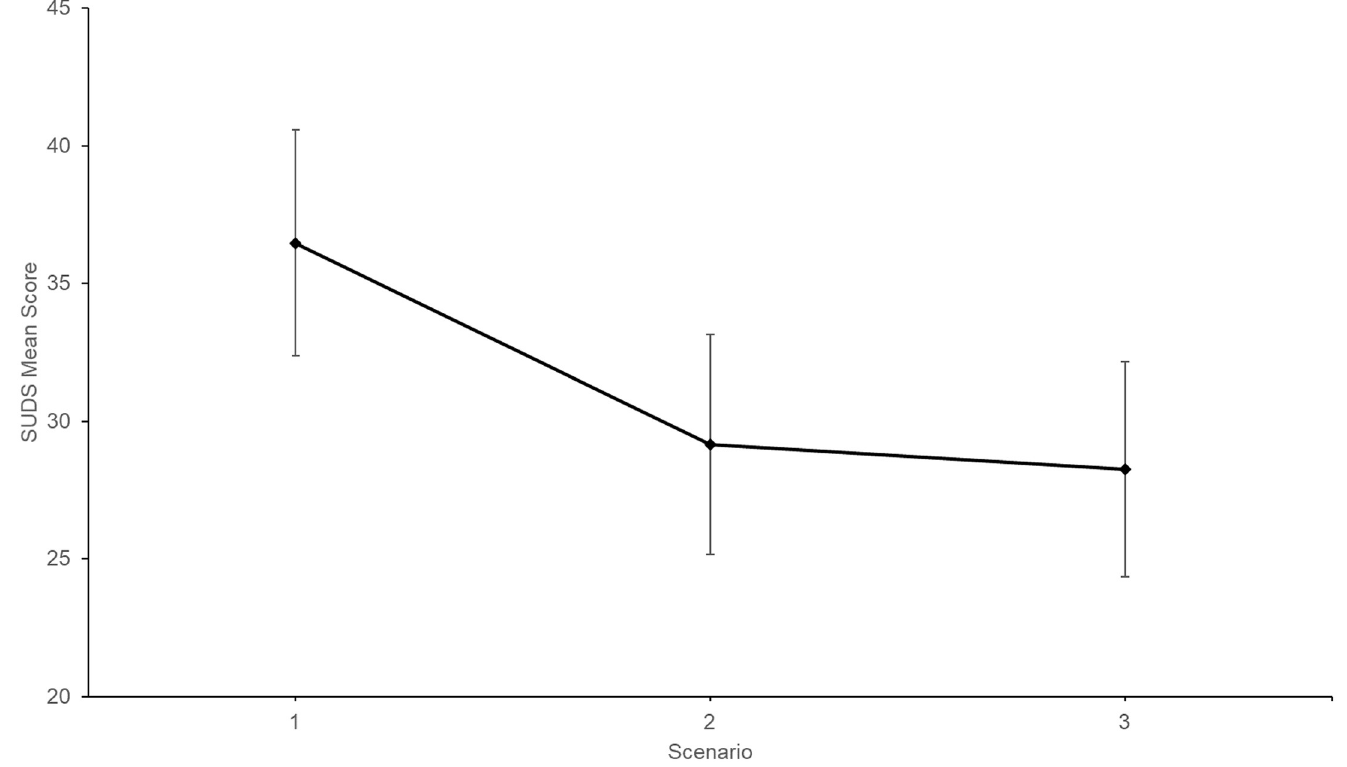
Fig 7. Subjective Units of Discomfort Scale (SUDS) Time 1 mean scores for each scenario. Time 1 = 00:00 minutes. Error bars represent standard errors. ( N = 19).